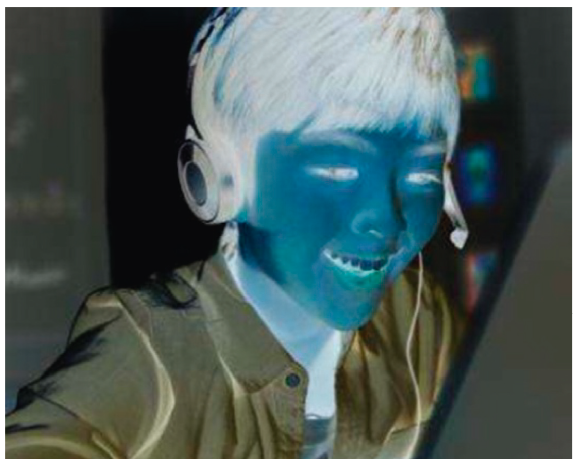
Figure 1: Theoretical wrapping phase